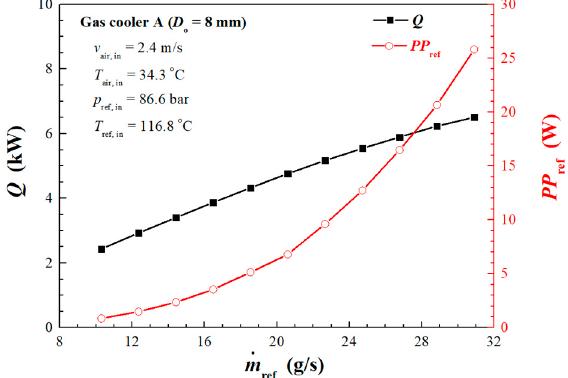
Figure 10. Influence of refrigerant mass flow rate on heat-transfer rate and sCO 2 pumping power for gas cooler A.